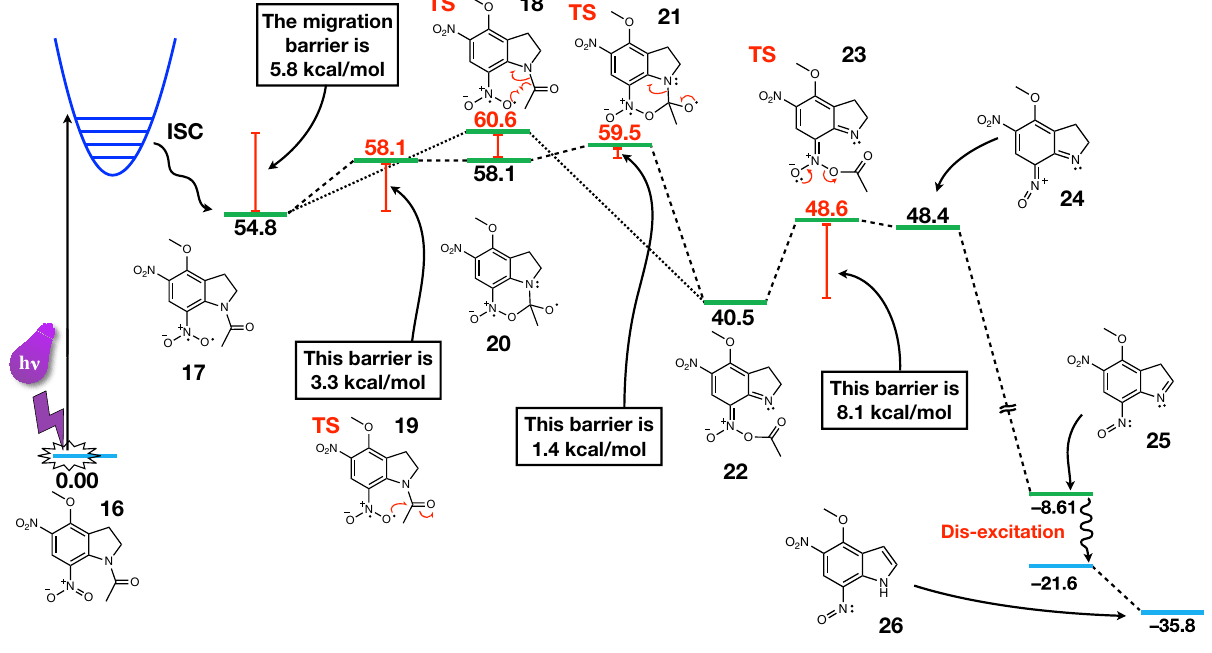
Figure 6. The reaction mechanism for the uncaging of MDNI-Ac. The singlet surface is indicated in blue, while the triplet surface is indicated in green. The CP–C mechanism is outlined with the dashed line, while the MP mechanism follows the dotted line. They both converge towards structure 22 , and then they proceed towards the products in the same way. The reported numerical values are Gibbs free energies calculated with respect to MDNI-Ac in the singlet state (structure 16 ), and they have been obtained at the ωB97X-D/def2-TZVP level of theory in water (C-PCM). All values are in kcal/mol. Structures 16 , 18 , 19 , 20 , 22 , 24, and 26 have been renumbered for better clarity, and they correspond to structures 9 , 11 , 12 , 10 , 13 , 14, and 8 , respectively, in Fig.